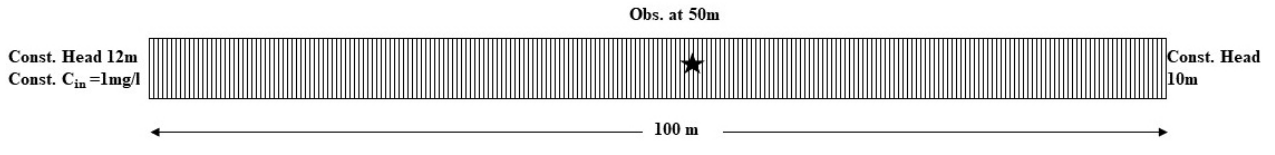
Figure 1. A 1D model domain assuming a free flow boundary at the right end and a higher gradient at the left end with a constant concentration point solute source.